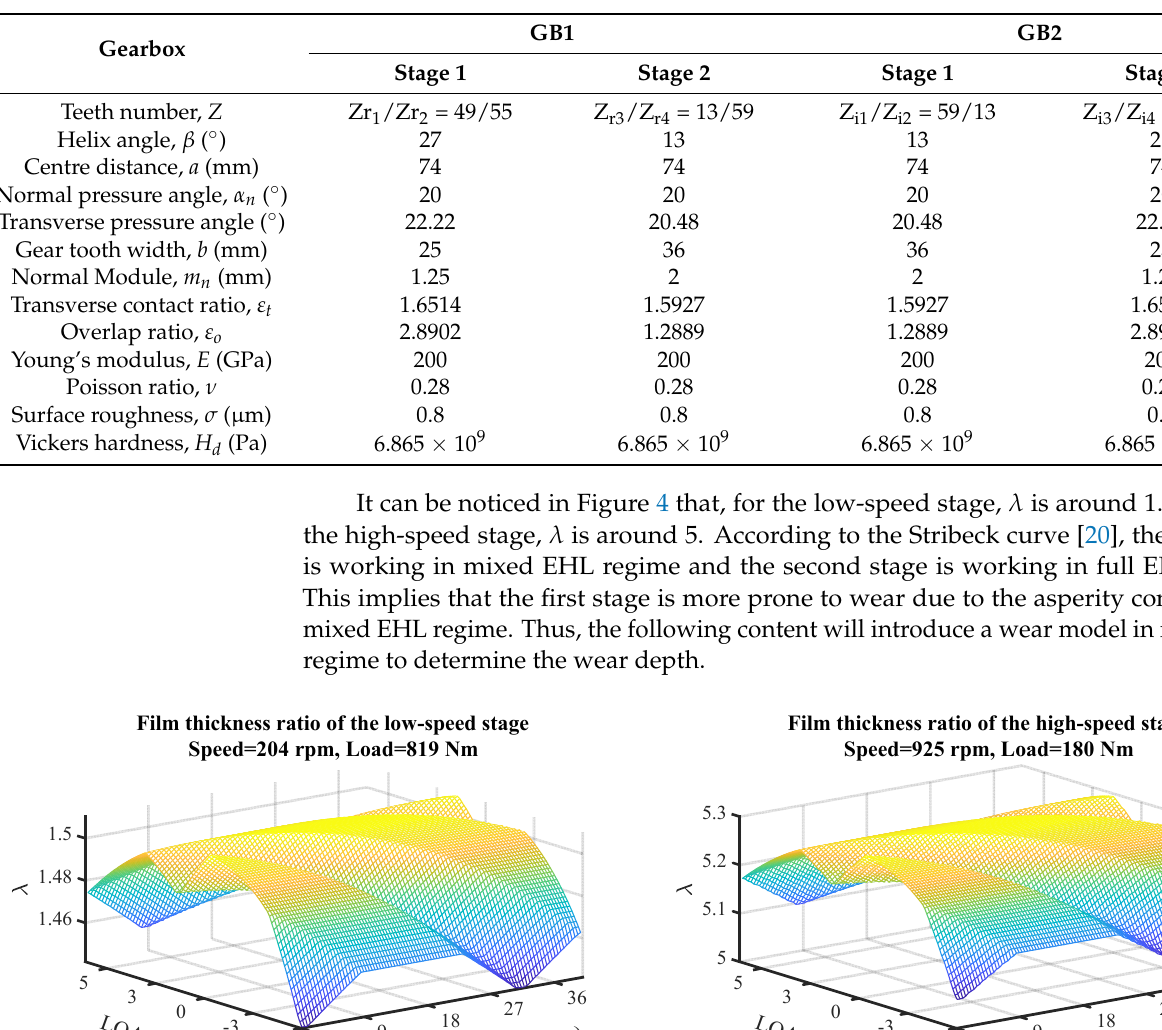
Table 2. Gearbox specifications.